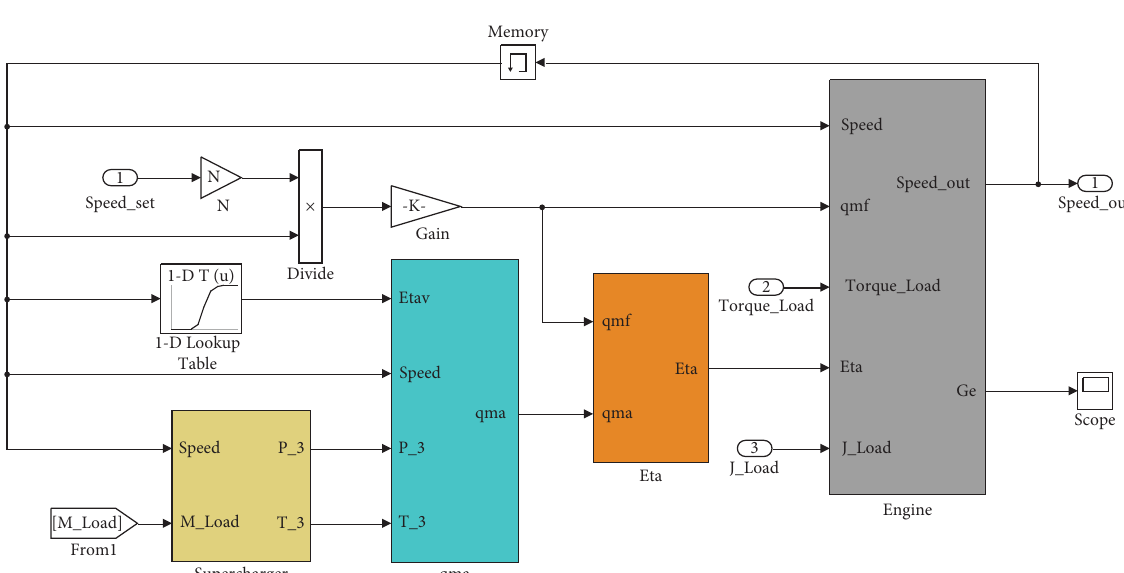
Figure 11: Diesel engine